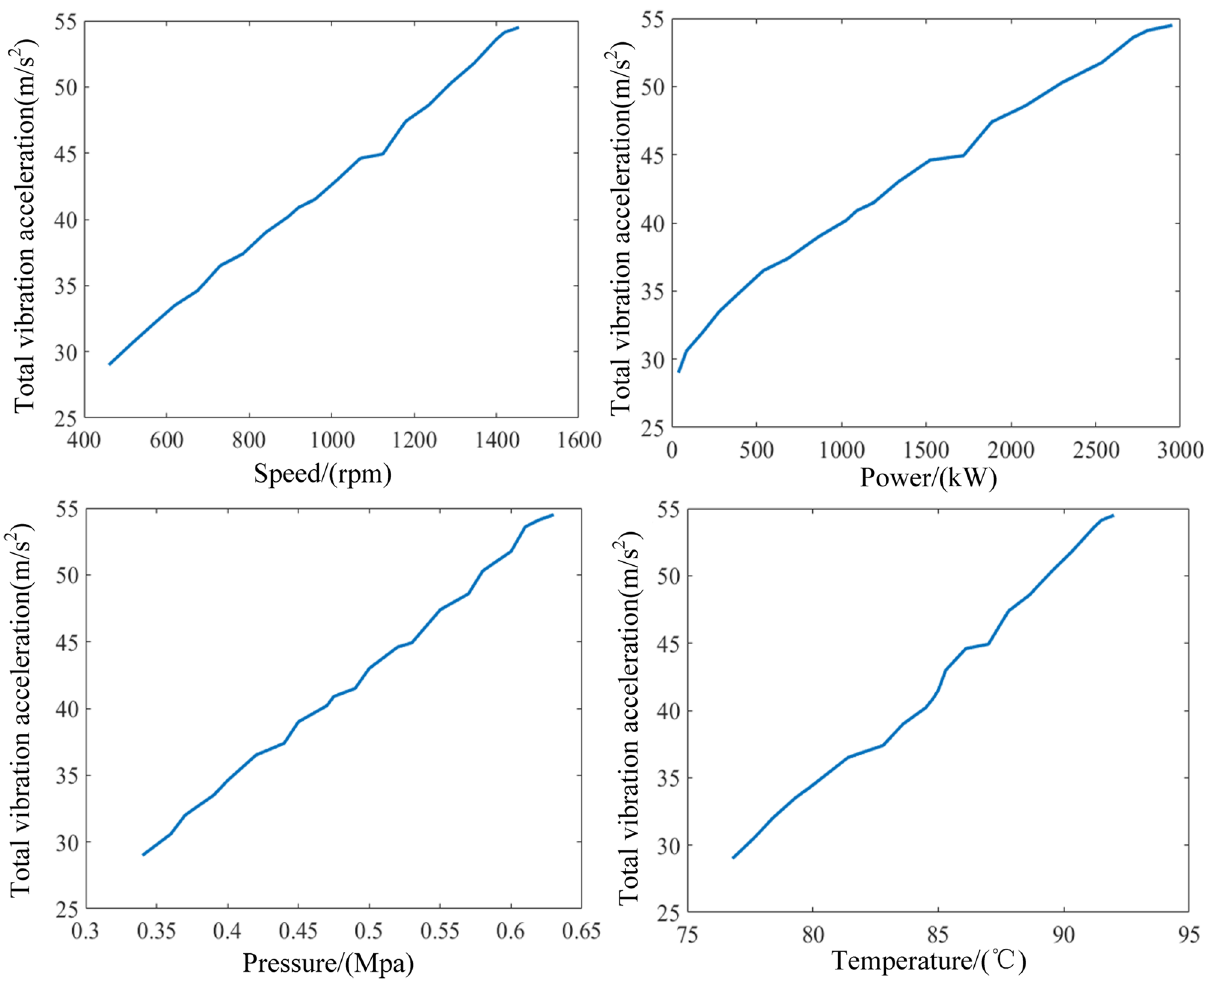
Figure 14. Influence of input parameters on